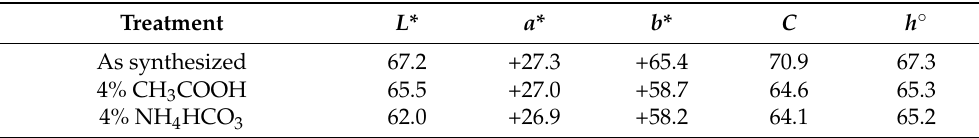
Table 4. L * a * b * Ch ◦ color coordinate data of the La 3 LiMn 0.97 Ti 0.03 O 7 pigment before and after